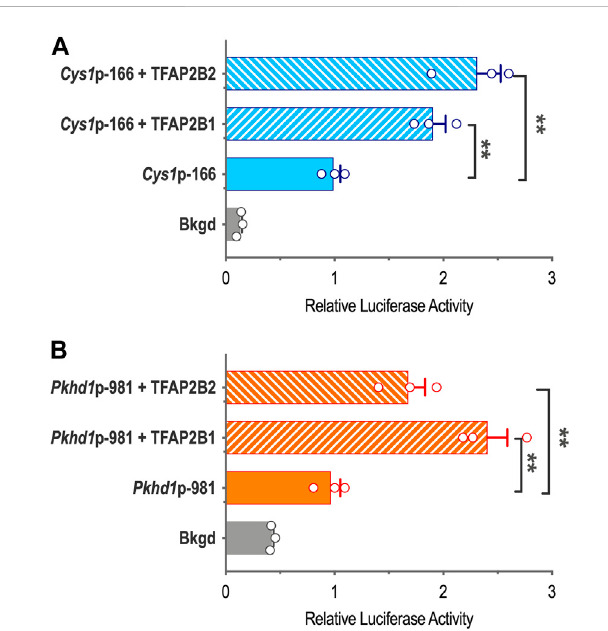
FIGURE 4 Cys1 and Pkhd1 promoter activation by TFAP2B1 and TFAP2B2. (A) The Cys1 p-166 luciferase reporter construct (containing one TFAP2B bindingsite,seeFigure3)wastransfectedintomIMCD-3cellswitheither TFAP2B2 orTFAP2B1 expression vectors.Relativeluciferaseactivity (normalizedto Cys1 p-166transfectedalone)isshown. (B) A Pkhd1 p-981 luciferase reporter construct (containing one TFAP2B binding site, similar to Pkhd1 p-950 in Figure 4C) analyzed as described above. For both Cys1 and Pkhd1 constructs, TFAP2B1 and TFAP2B2 co-transfection signi fi cantly (** p < .01) increased luciferase activity compared to transfection ofthe Cys1 or Pkhd1 luciferase reporter alone. The error bar indicates